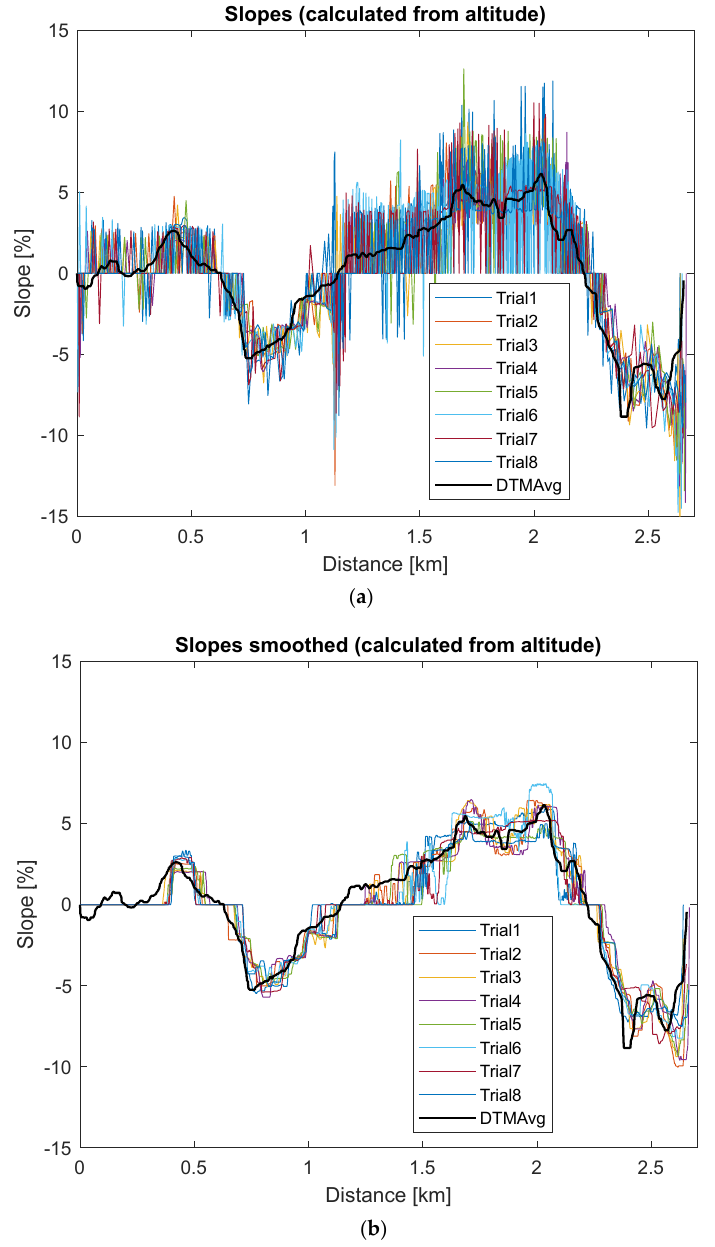
Figure 19. ( a ) Calculated slopes based on height without smoothing. ( b ) Calculated slopes based on height without smoothing.